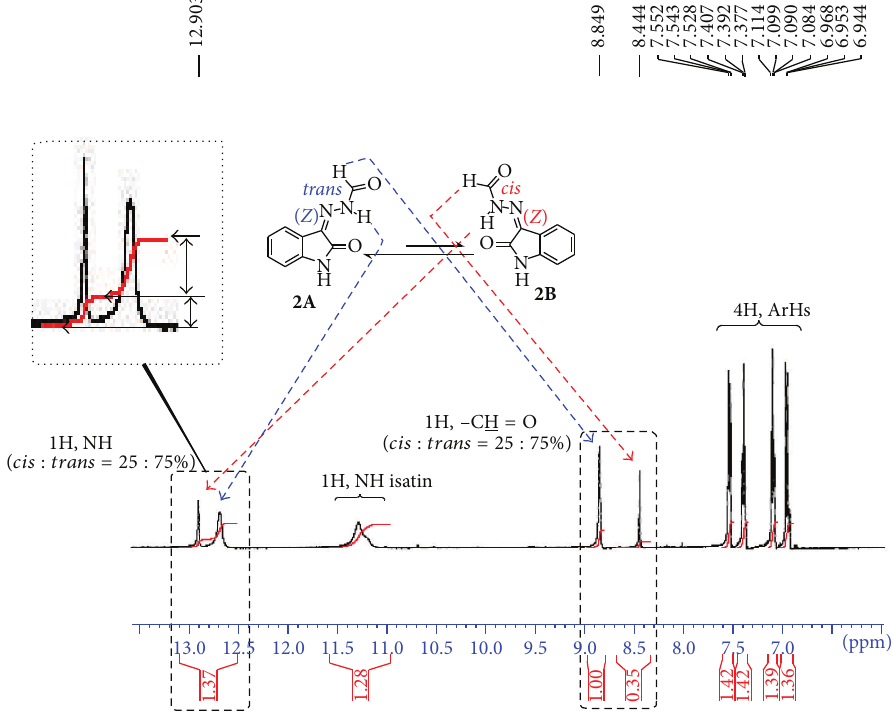
Figure 2: 1 H NMR (DMSO- 𝑑 6 ) of compound 2